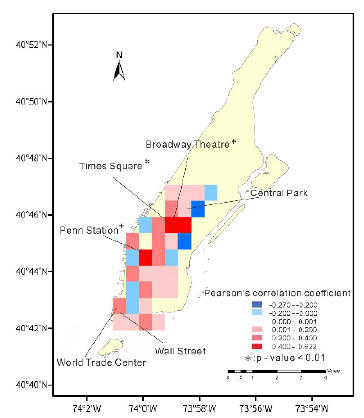
Figure 6 Sensitive map of emotion score to the stock